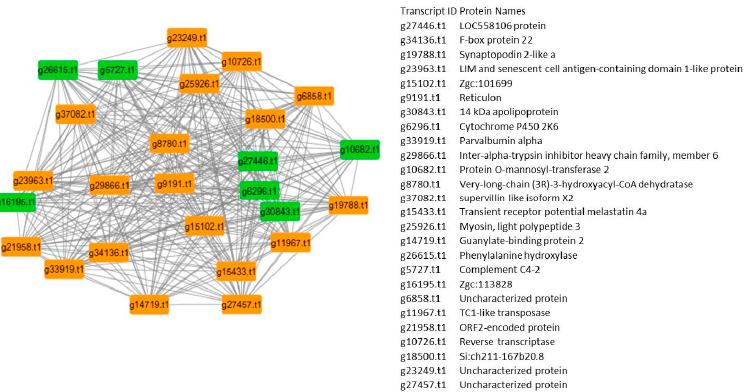
Figure 9. Protein–protein interaction network of control vs. treated. Different colors indicate different components identified in the gene lists. Table 3. The hub genes and their roles, and functional evidence. Sl. No.